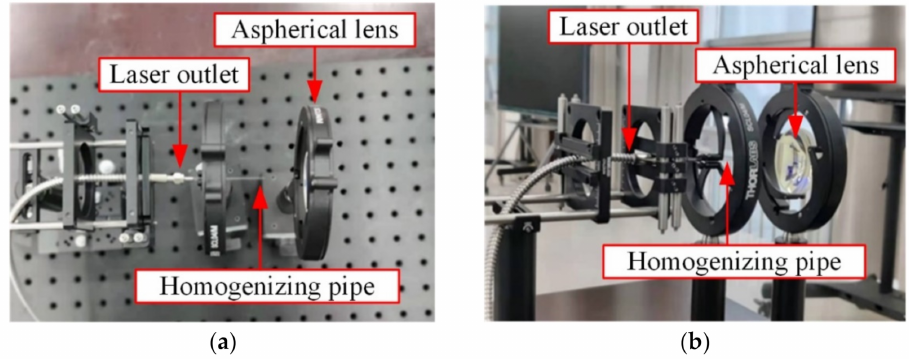
Figure 11. Experimental setup of the illumination system: ( a ) Top view; ( b ) Side